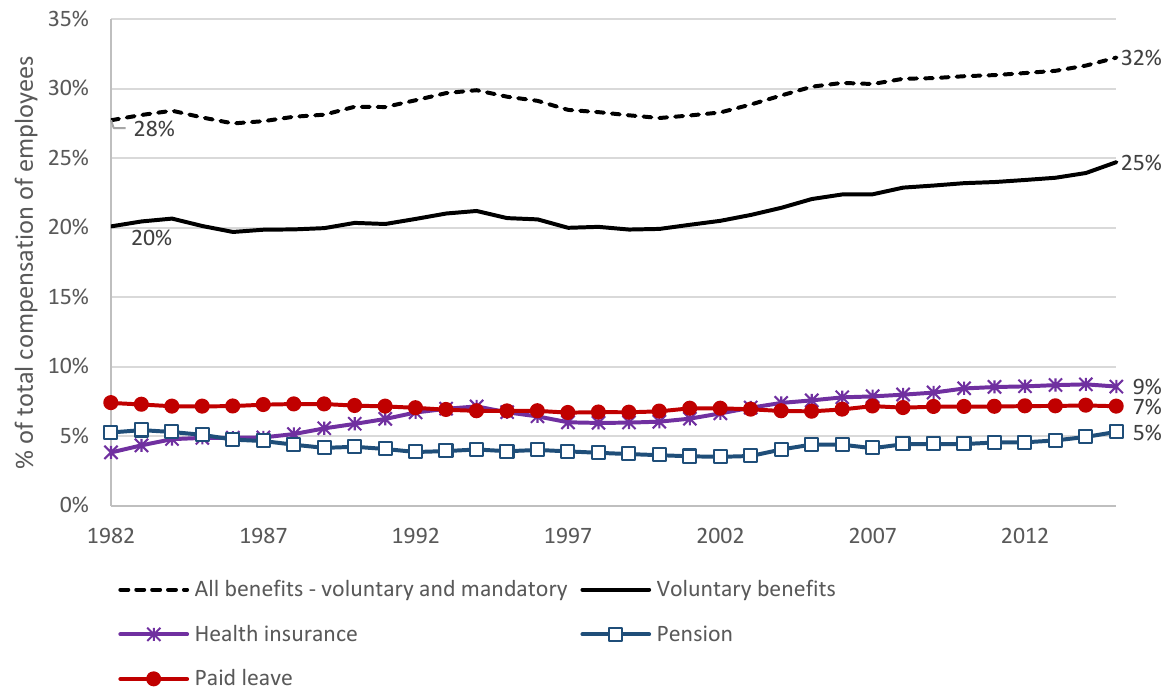
Figure 1: Voluntary and mandatory supplements to wages and salaries as a percentage of the total compen- sation of employees, 1982–2015. Notes: Data are derived from Bureau of Labor Statistics (BLS)